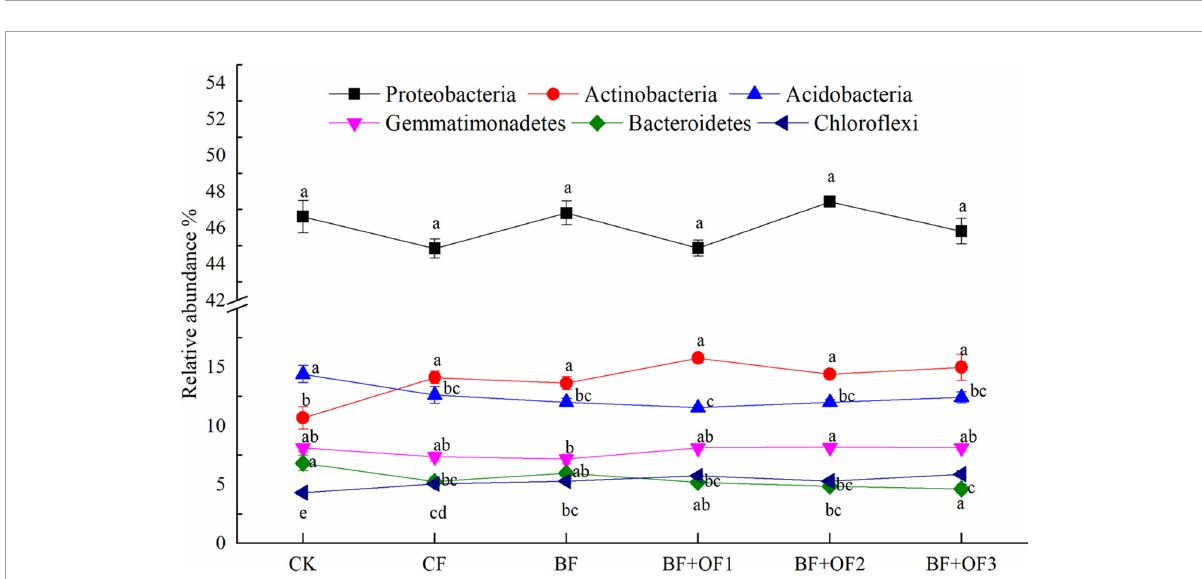
FIGURE4 Relative abundances of six dominant bacteria at the phylum level under different fertilization treatments. CK, no fertilizer; CF, chemical fertilizers (conventional dosage for this region); BF, balanced fertilizer (70% of total chemical fertilizer); BF + OF1, BF + OF2, and BF + OF3,